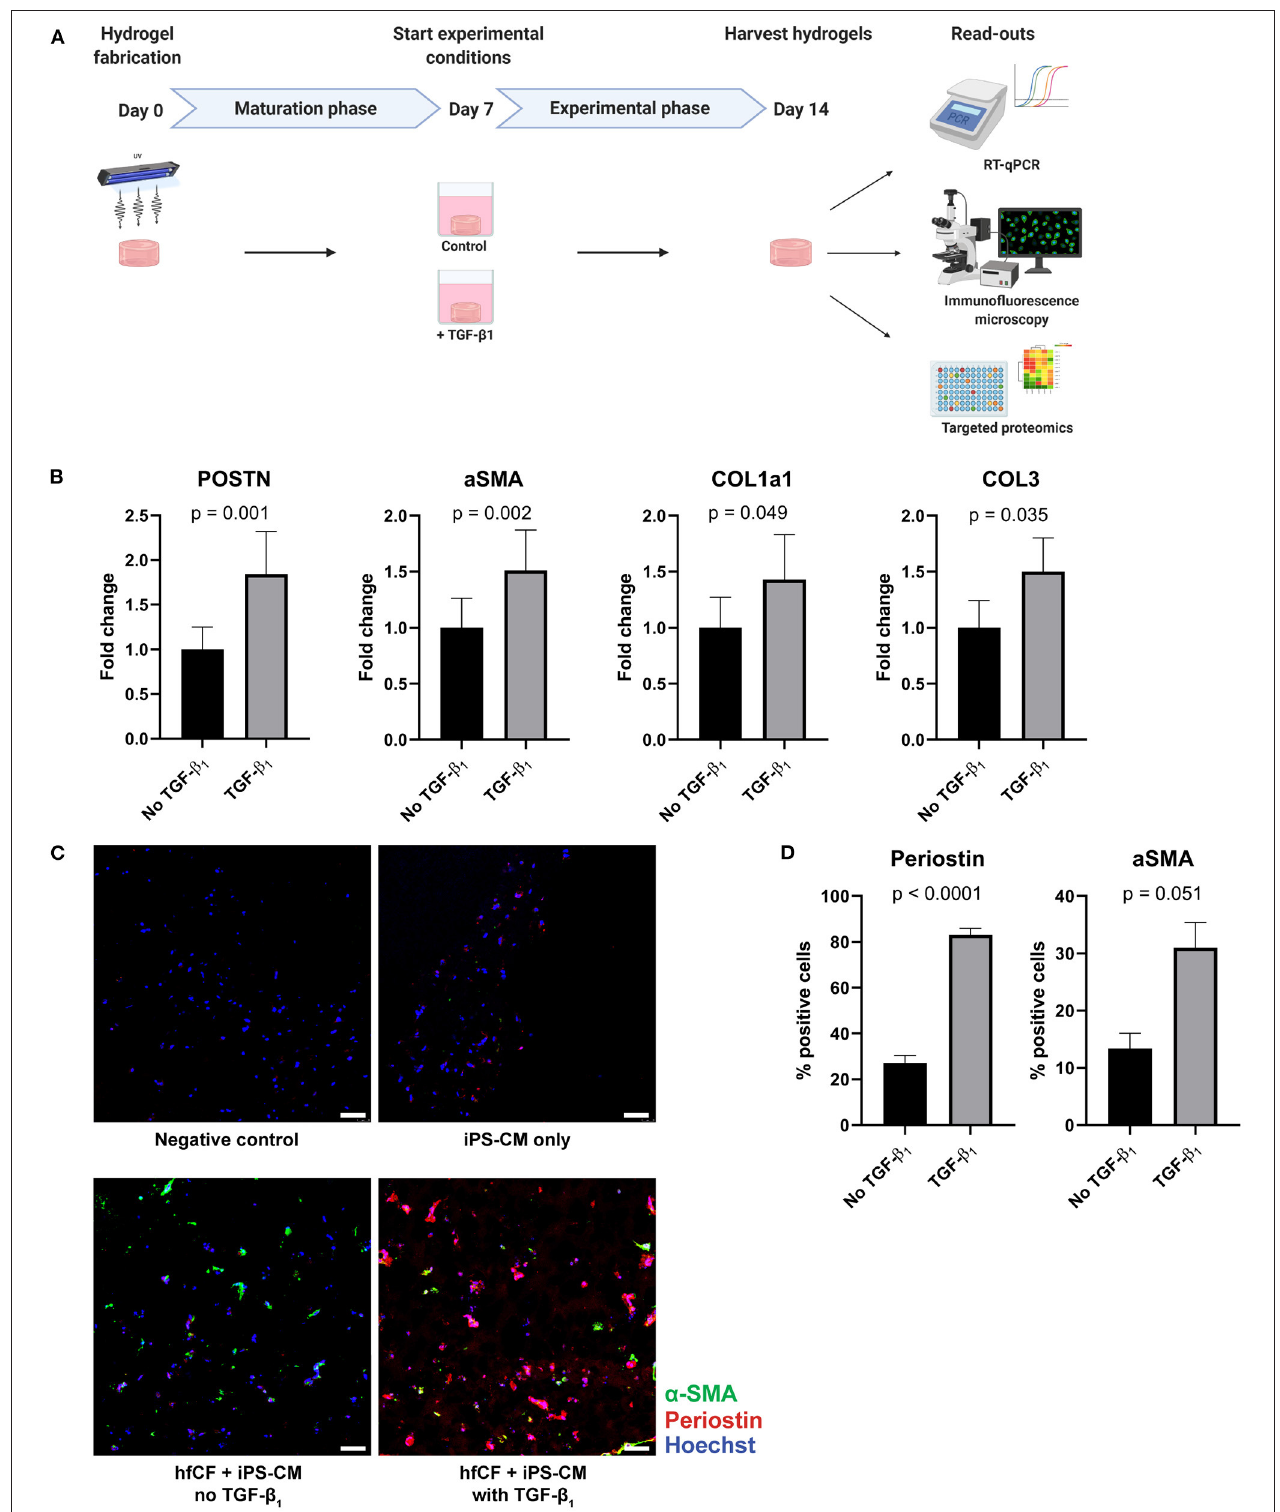
FIGURE 2 | TGF- β 1 induces a fibrotic response in cardiac tissue constructs. (A) Timeline of the experiment. Cardiac tissue constructs were fabricated at day 0 and cultured until day 7. On day 7, experimental conditions were started. Two experimental conditions were created: TGF- β 1 was added in the first group in a